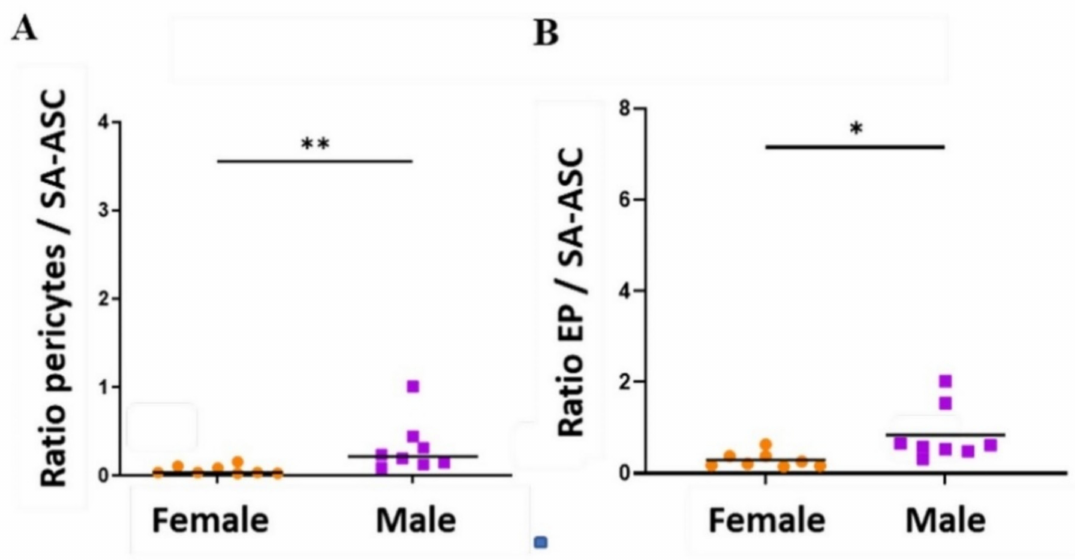
Figure 4. Differences between female and male patients in the progenitor cell ratios in the stromal vascular fraction from LA samples. The pericyte/SA-ASC ratio ( A ) and the EP/SA-ASC ratio ( B ) were calculated from the quantitative data shown in Figure 2 (percentage of nucleated cells for each cell population). The data are expressed as symbols representing each female patient ( n = 8) or male patient ( n = 8) with the group median ( A ) or mean ( B ). Statistical analysis was performed using the Mann–Whitney test ( A ) or unpaired t-test ( B ). p -values: (*) p < 0.05 (**) p <